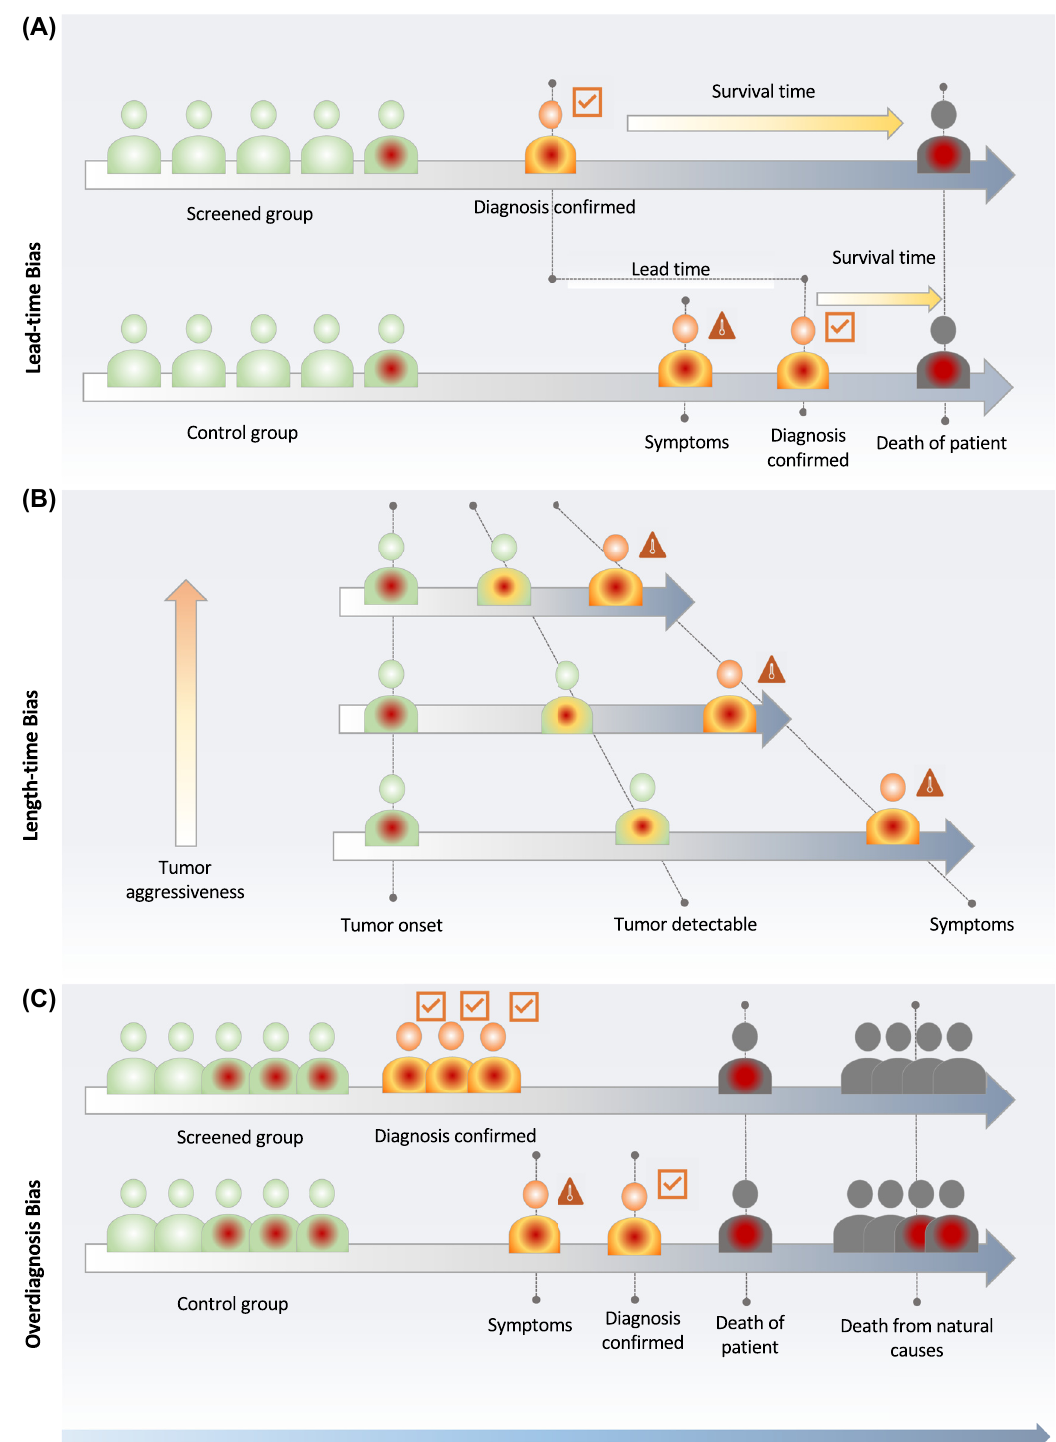
Figure 1: Biases that may result in systematic overestimation of the benefits of cancer-screening. Lead-time bias (A), length-time bias (B), and overdiagnosis bias (C) may arise when the natural history of asymptomatic disease is not taken into consideration (Figure adapted from Gates, 2014